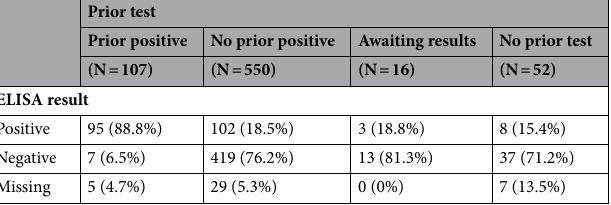
Table 3. IgG ELISA results as a function of self-reported prior SARS-CoV-2 diagnostic test outcome among returning student cohort